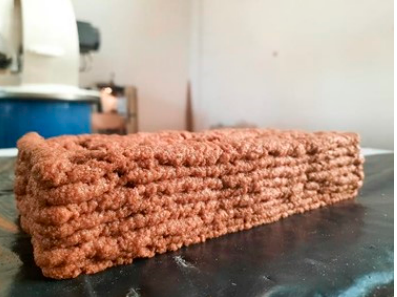
Figure 10. The extruded lattice brick (Image credit: Authors).